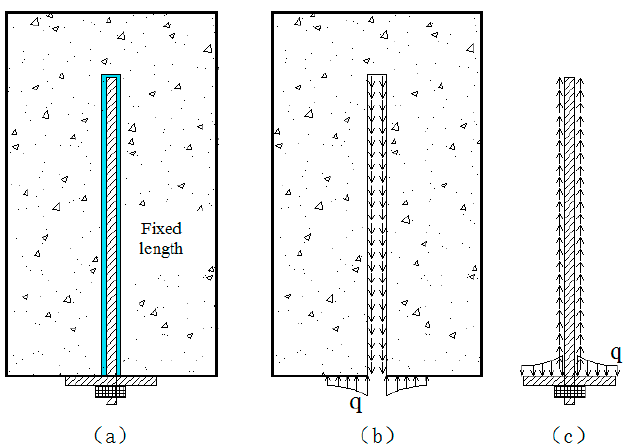
Figure 7. Mechanism of the non-prestressed anchor. ( a ) the schematic of “rock bolt − anchorage body − surrounding rock” supporting structure, ( b ) the force schematic of surrounding rock, ( c ) the force schematic of the rock bolt.